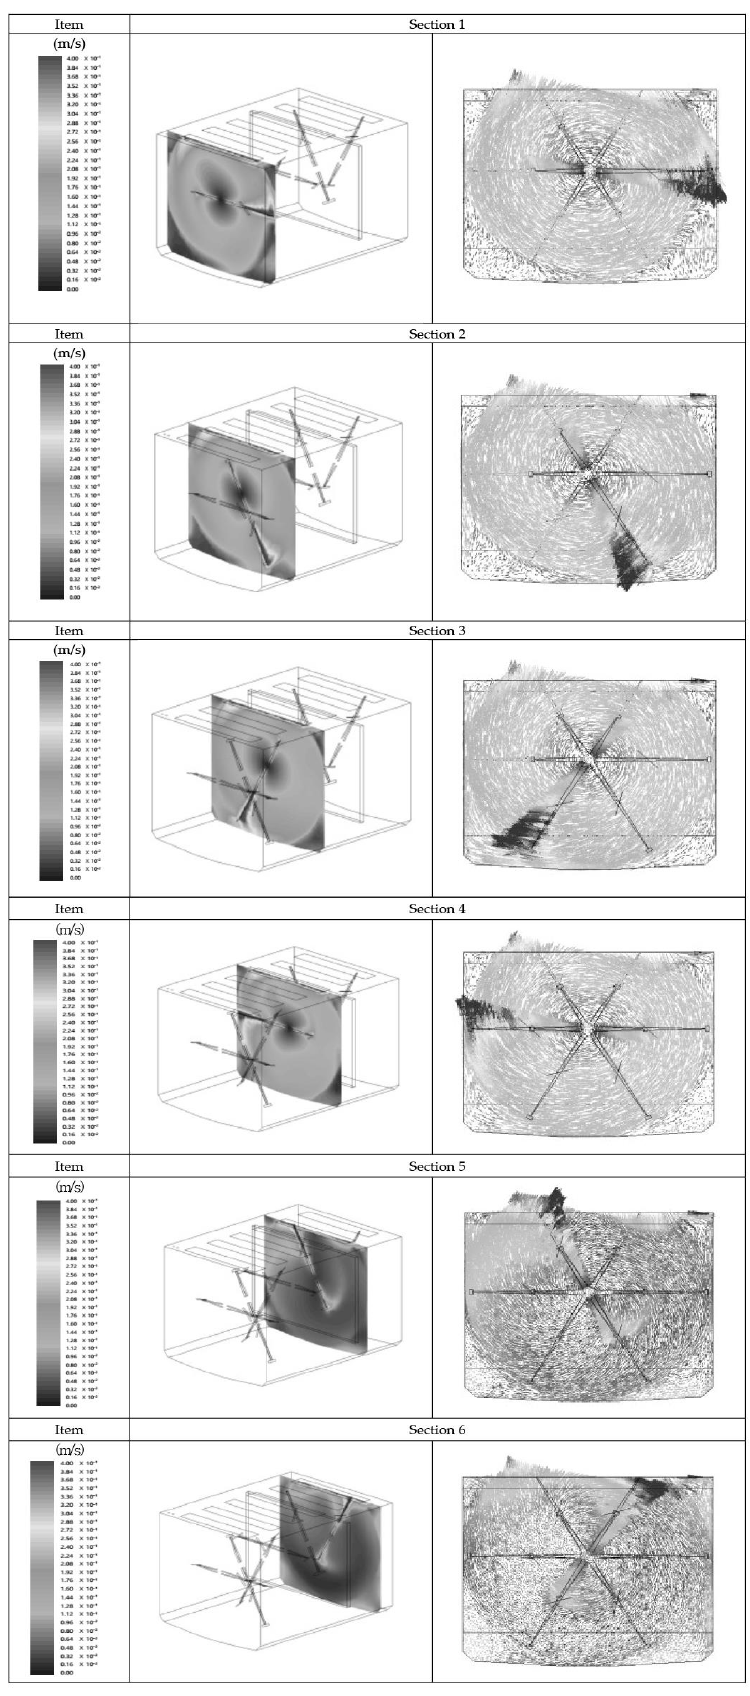
Figure A1. Flow velocity distribution as per the CFD simulation.